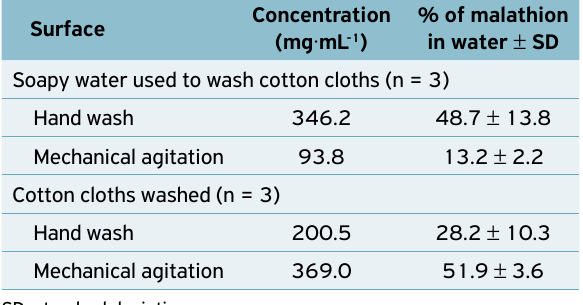
Table 2. Percentage of malathion removed from soapy water and washed cotton cloths [hand wash (A) and mechanical agitation (B)].